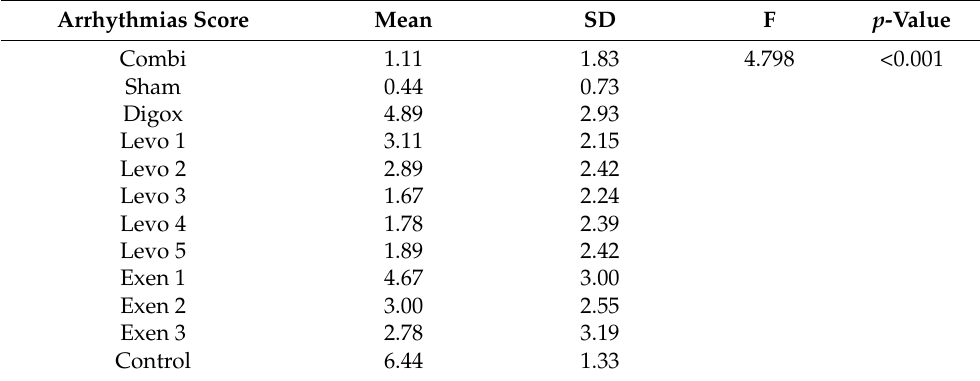
Table 9. Effect of group on arrhythmias score.